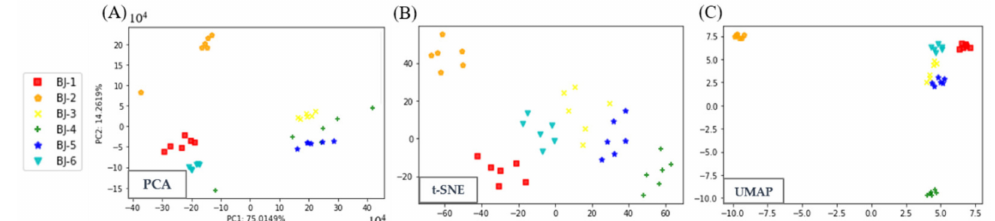
Figure 4. Visualization of the liquor dataset by PCA, t-SNE and UMAP. Each shape represents a sample. ( A ) The PCA plot based on features extracted by KPIC2 of the liquor dataset, and the percentage of variance explained by each selected component is displayed on the axis; ( B ) the t-SNE plot based on features extracted by KPIC2 of the liquor dataset; ( C ) the UMAP plot based on features extracted by KPIC2 of the liquor dataset.